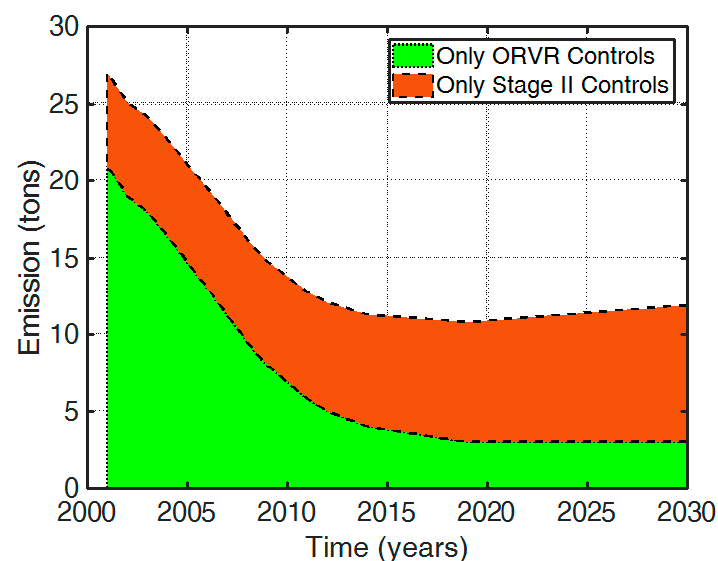
Figure 1. Comparisons of evaporative emissions between onboard refueling vapor recovery (ORVR) and Stage II controls [4].